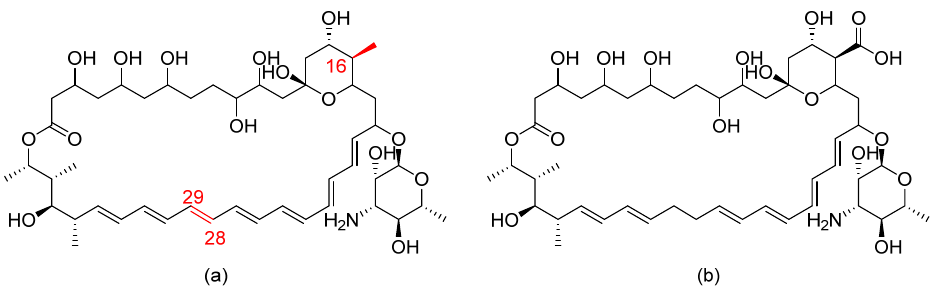
Figure 14. The chemical structures of ( a ) BSG005 and ( b ) nystatin. The structural modifications are shown in red.